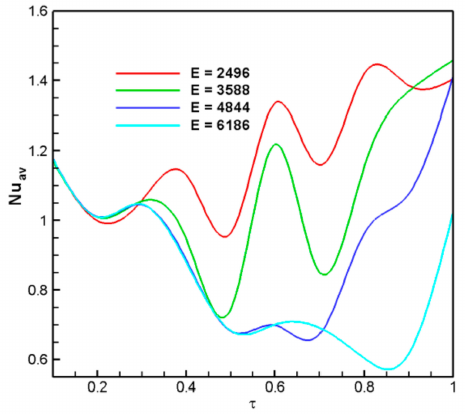
Figure 2. Grid independency study with δ = 0.04, N = 1, and Gr = 10 7 .